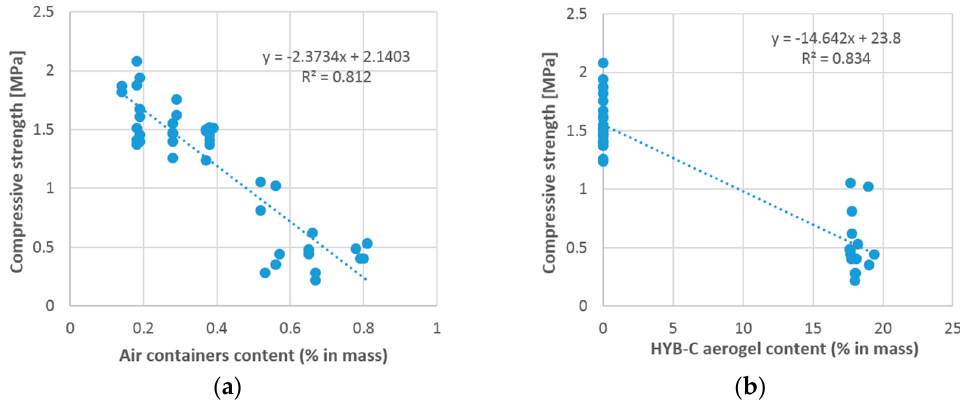
Figure 5. Compressive strength in function of the: ( a ) the air entrainers content (% in mass); and ( b ) HYB-C aerogel content (% in mass).